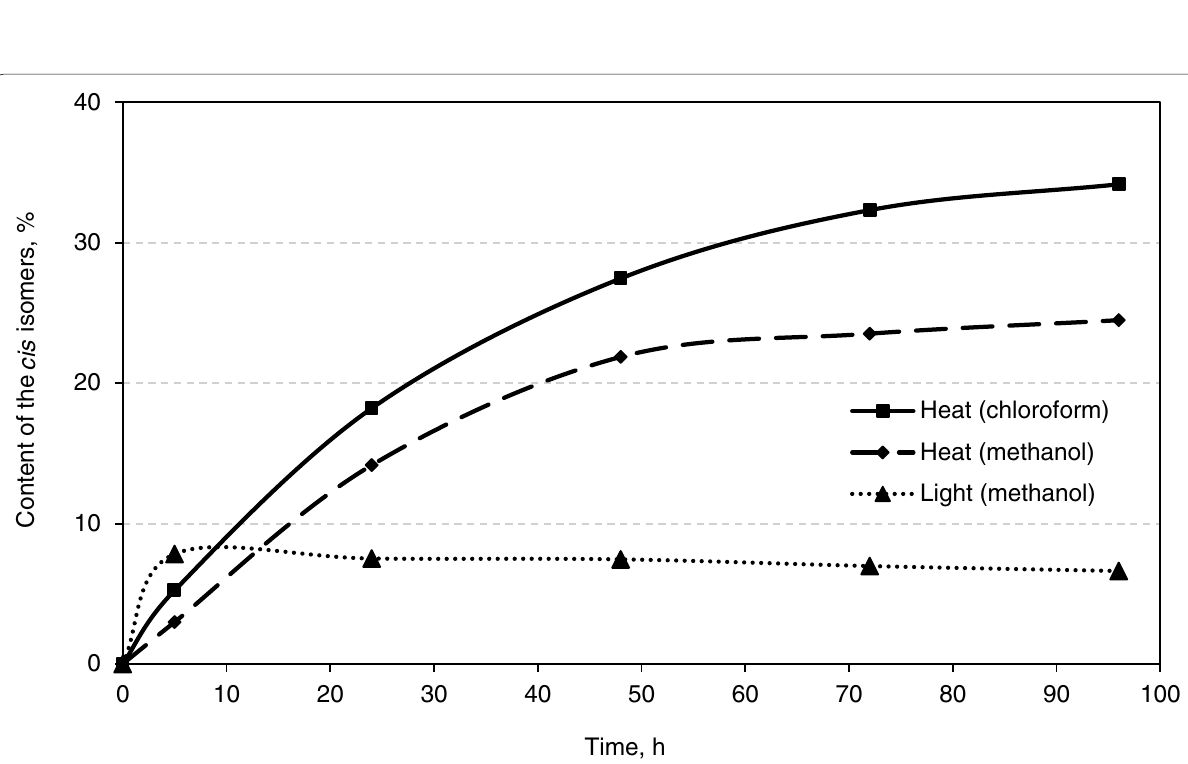
Fig. 3 Change in the total content of astaxanthin Z -isomers under different conditions: (Heat)—incubation at 40 °C in the dark; (Light)—incubation at room temperature under blue light (28,000